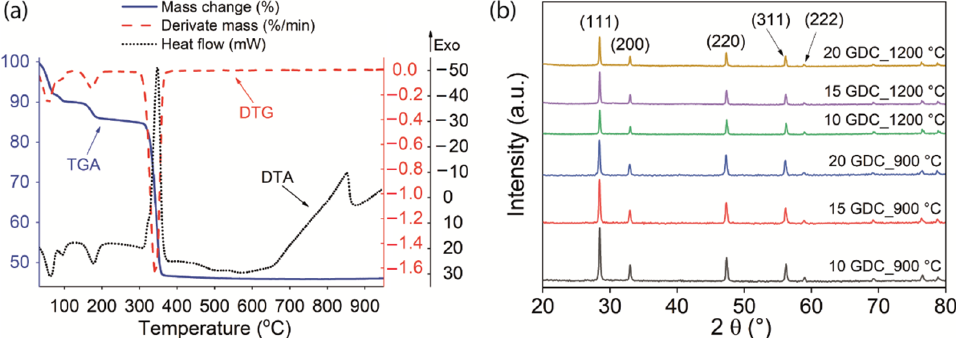
Figure 1. Thermal analysis curves ( a ) for 10-GDC ceramic powders and ( b ) the X-ray diffraction patterns of GDC nanopowders, calcined at 900 °C and 1200 °C.